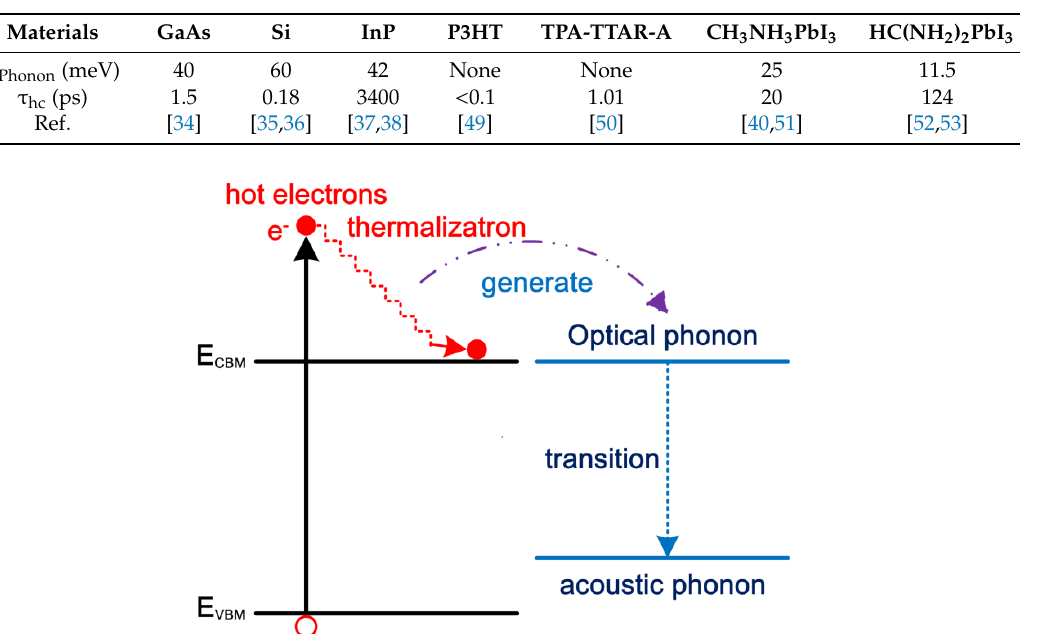
Table 1. Optical phonon energies ( E Phonon ) and hot-carrier lifetimes ( τ hc ) of various inorganic materials